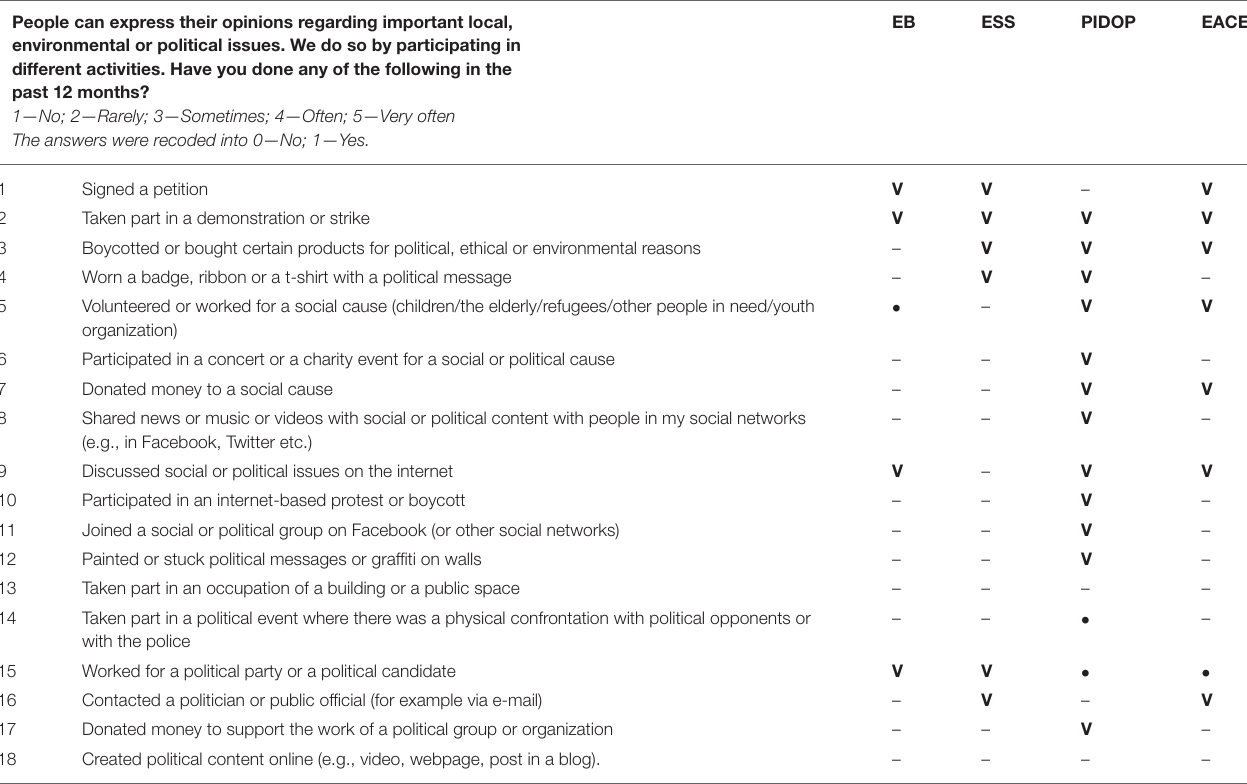
TABLE 2 | Questions about social and political participation. People can express their opinions regarding important local, environmental or political issues. We do so by participating in different activities. Have you done any of the following in the past 12